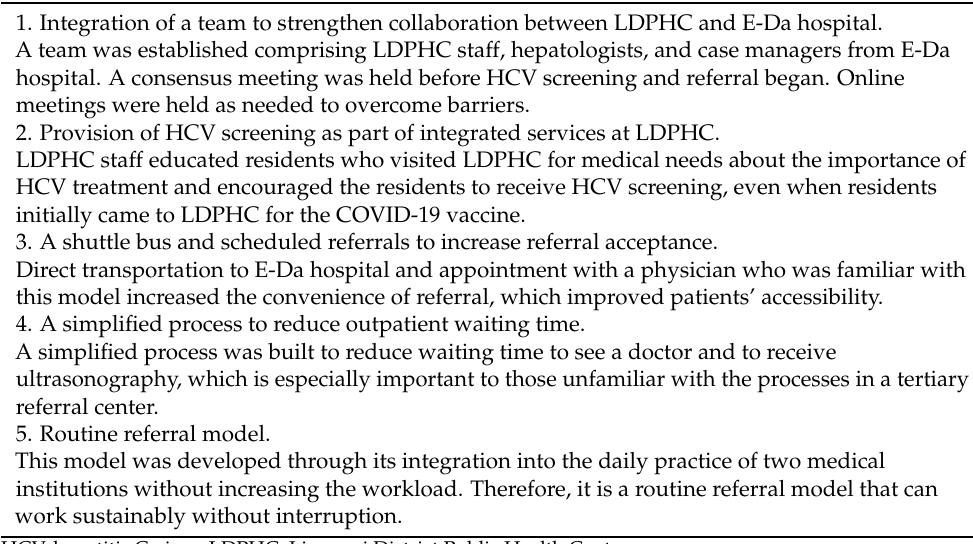
Table 1. Strategies to overcome barriers in HCV care cascades.